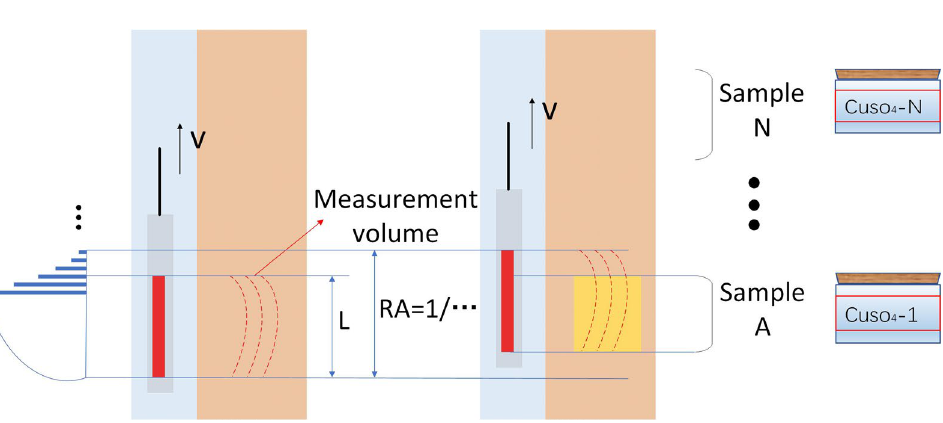
Figure 8. Pulse sequence timing control of nuclear magnetic circuit. ( a ) Pulse sequence dynamic switching simulation results including receive control signal, dump control signal and RF control signal; ( b ) the signal obtained by the oscilloscope test.